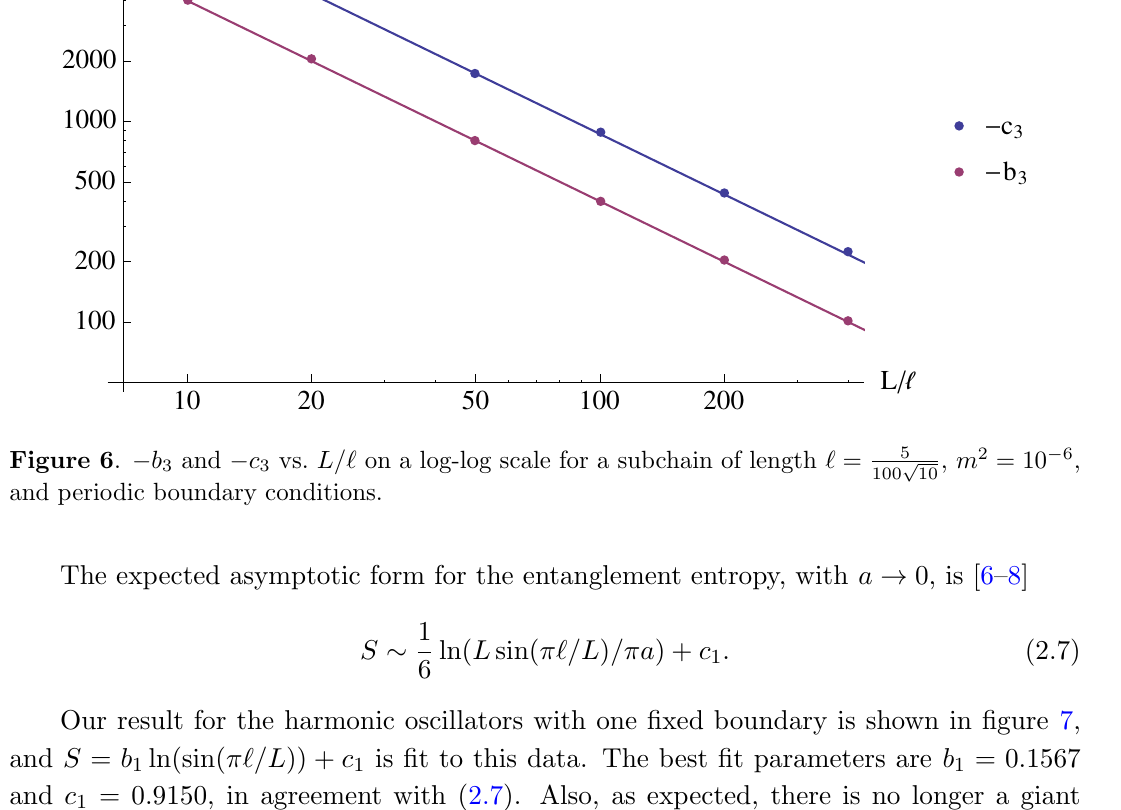
Figure 6 . (cid:0) b 3 and (cid:0) c 3 vs. L=‘ on a log-log scale for a subchain of length ‘ = 5 and periodic boundary